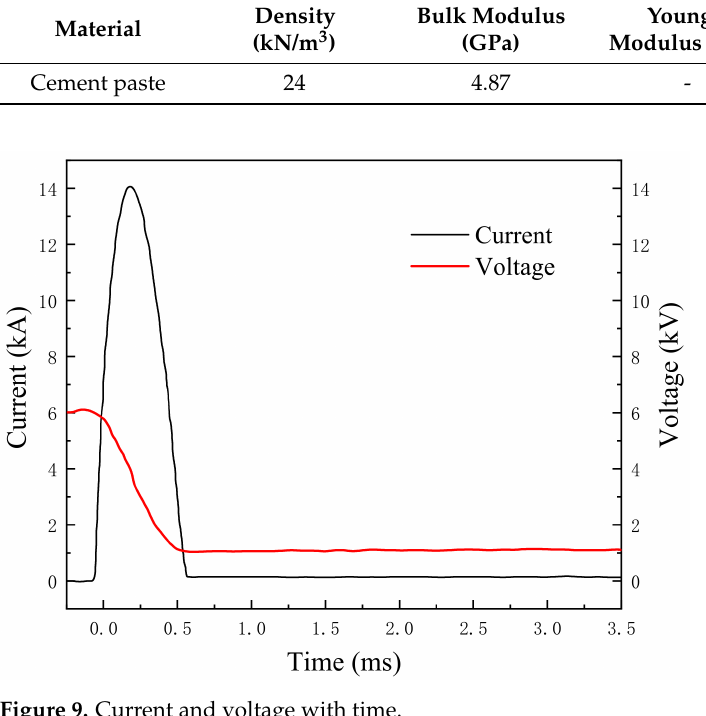
Figure 9. Current and voltage with time.